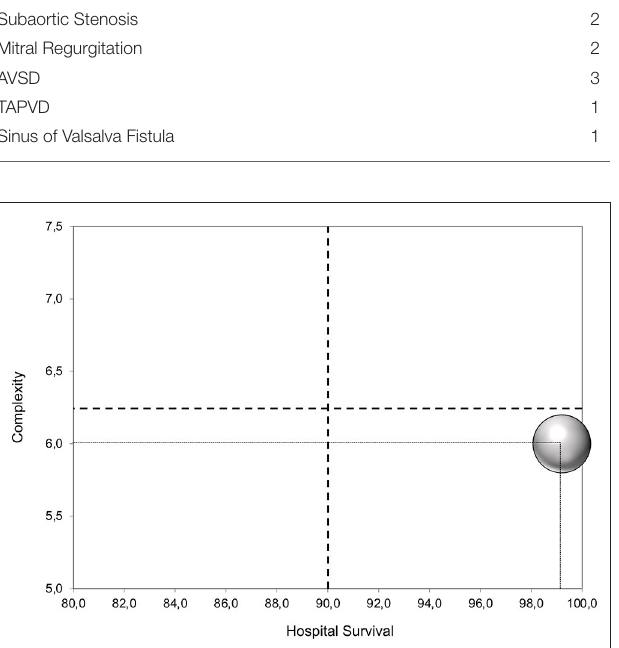
FIGURE 2 | Surgical performance.